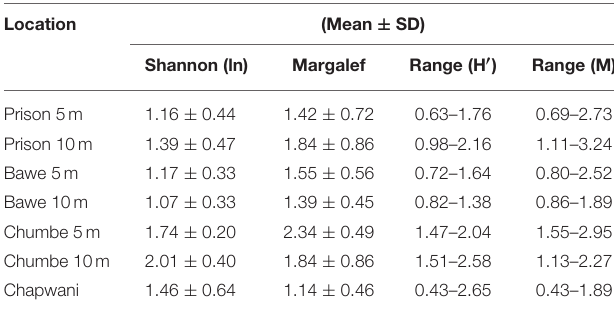
TABLE 1 | Comparative table showing the mean and standard deviation and range in values for the Shannon-Wiener biodiversity index and Margalef richness. Location (Mean ±